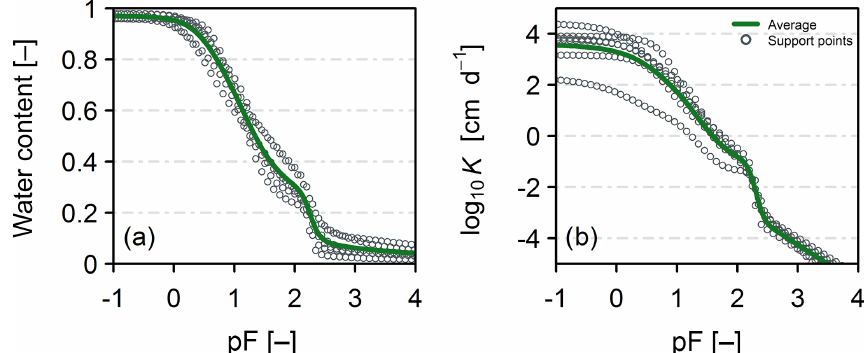
Figure 3. Example of the averaging process for (a) water retention curves and (b) hydraulic conductivity curves, shown for depth 7.5cm (five replicates). Despite the variability of the individual curves, the key structural features are